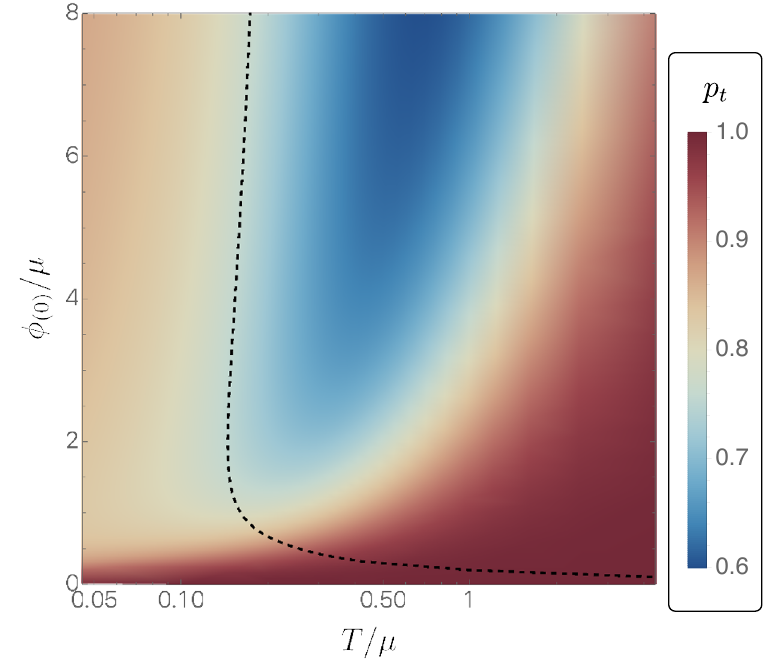
Figure 5 . Near-singularity Kasner exponent p t as a function of the boundary temperature T=(cid:22) and strength of the deformation (cid:30) =(cid:22) . The scalar (cid:12)eld is taken to have m 2 = (cid:0) 2. The dashed (0) line shows the transition from the singularity bending up to bending down in the Penrose diagram, discussed in section